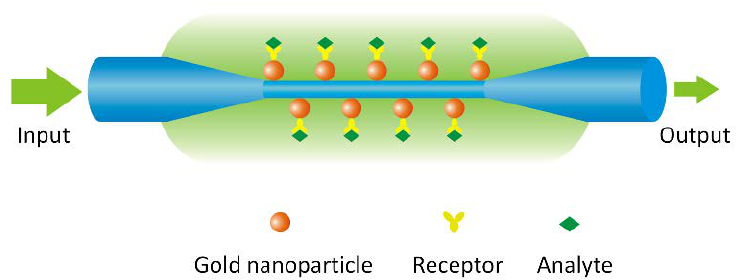
Figure 1. A schematic diagram showing the principle of optical micro/nanofiber (OMNF)-based localized surface plasmon resonance (LSPR) sensor.